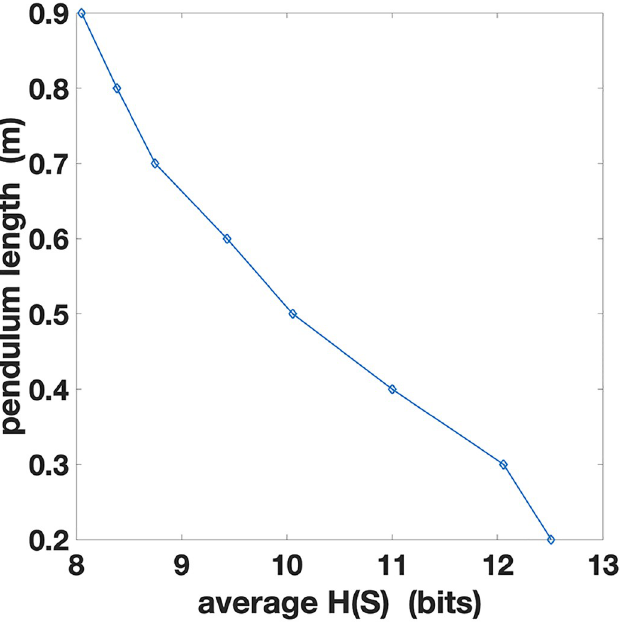
Fig 6. State entropy H ( S ) averaged across trials with the same pendulum length L . The abscissa represents the state entropy and the ordinate represents the pendulum length to allow direct comparison with Fig 4.